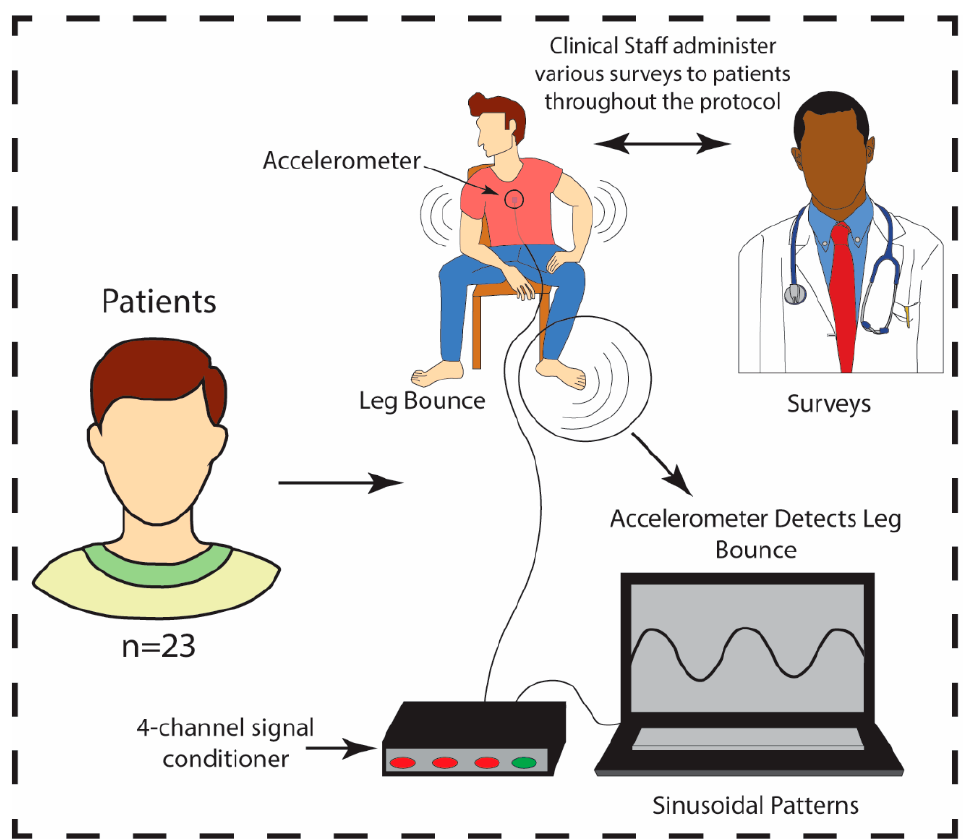
Figure 1. A sample size of n = 23 patients participated in the protocol. Patients were administered COWS by the clinical staff throughout the protocol while patient movements were tracked via accelerometry. Movement data was monitored by a triaxial accelerometer connected to a 4-channel signal conditioner powering the accelerometer. The entire unit was connected to a laptop. The accelerometer was positioned at the center of the sternum and recorded in real-time.